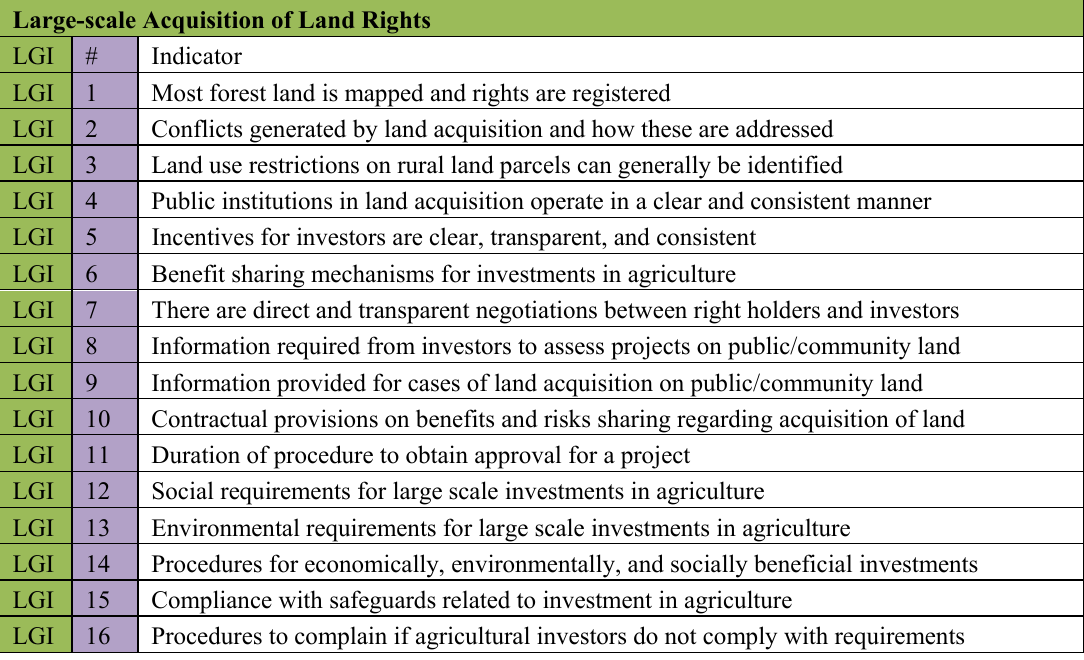
Large-scale Acquisition of Land